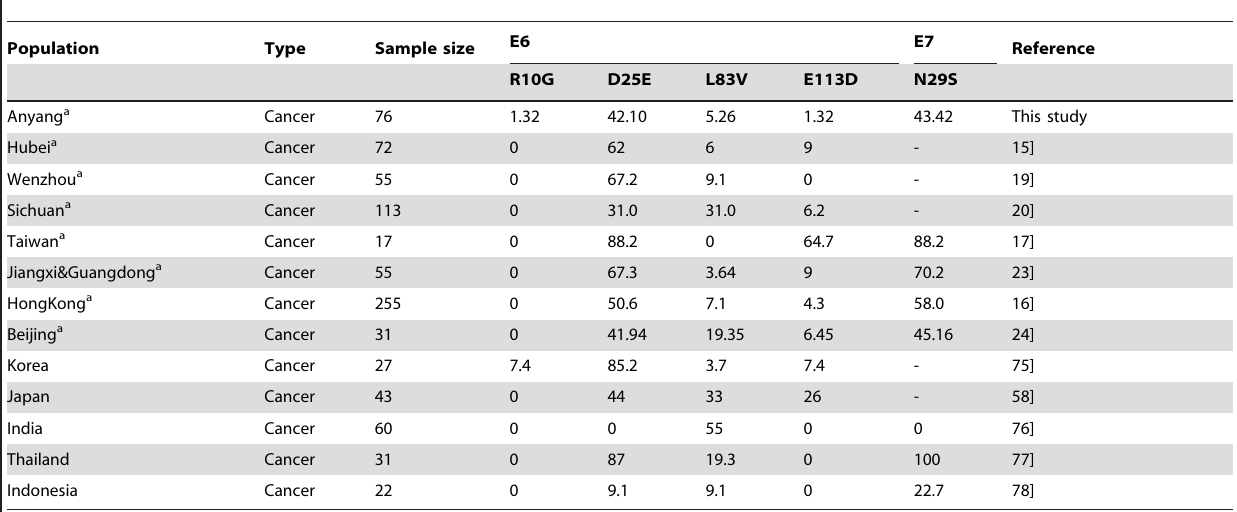
Table 3. E6/E7 positively selected sites and their associated frequencies curated from previous studies